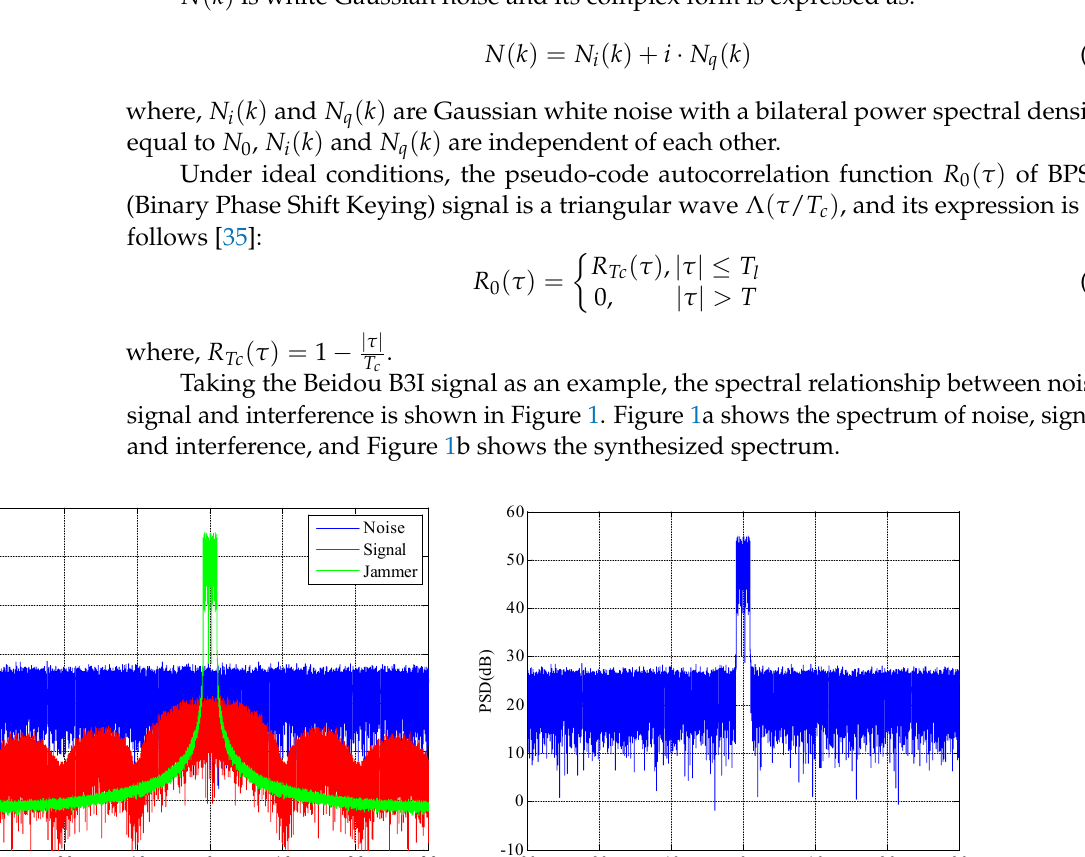
Figure 2. Autocorrelation characteristics of navigation signals. 2.2. Time-Domain Anti-Jamming Model The structure of the single-antenna-based time-domain adaptive anti-jamming filter is shown in Figure 3.